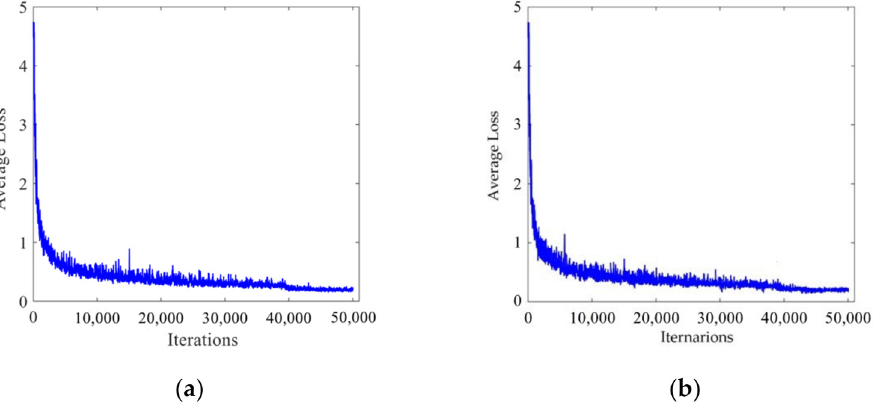
Figure 7. Relation curve of average loss and the number of iterations. ( a ) LISA traffic light data set. ( b ) LaRa traffic light data set.